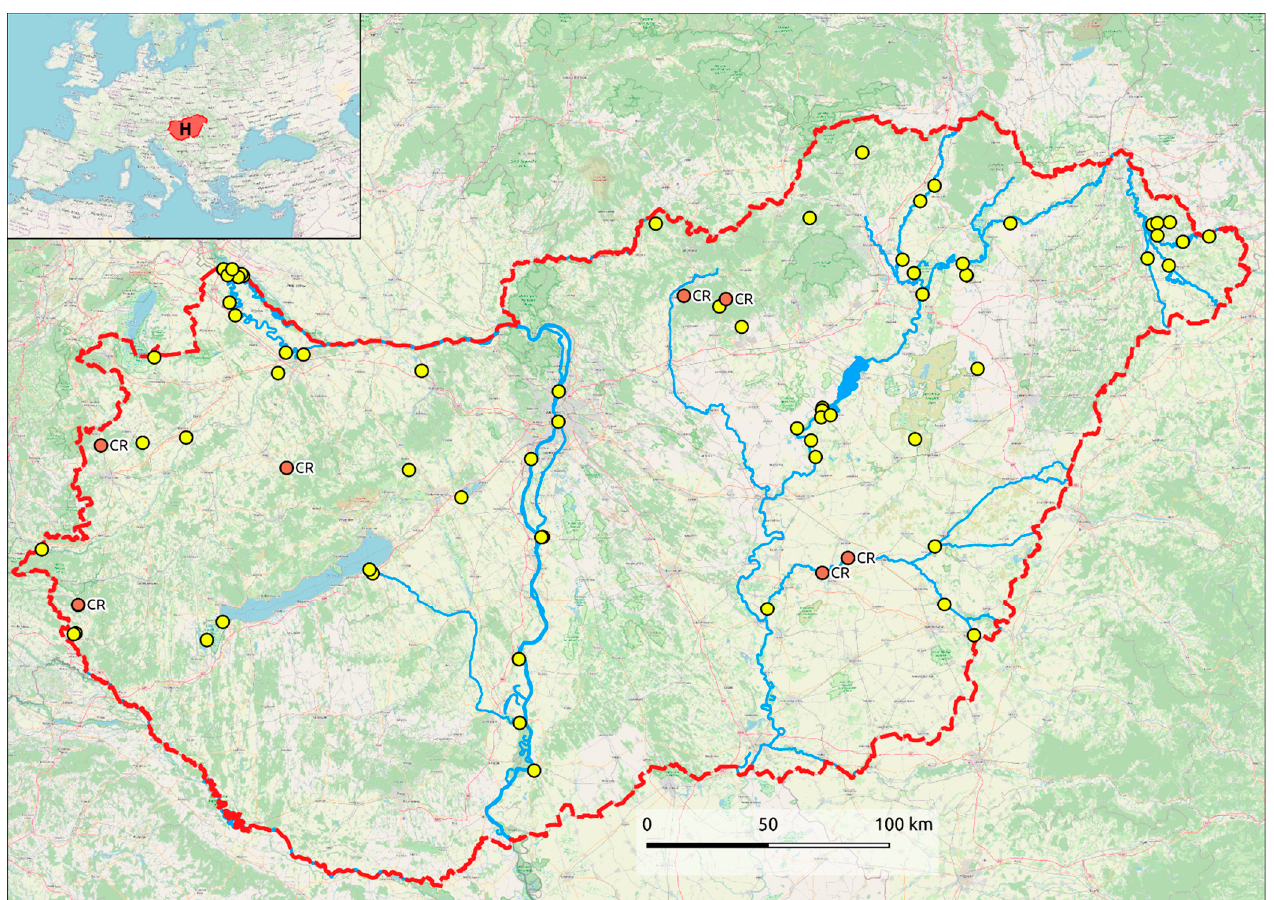
Figure 1. Location of the surveyed Hungarian water management facilities (yellow circles) and the installed CRs (red circles).